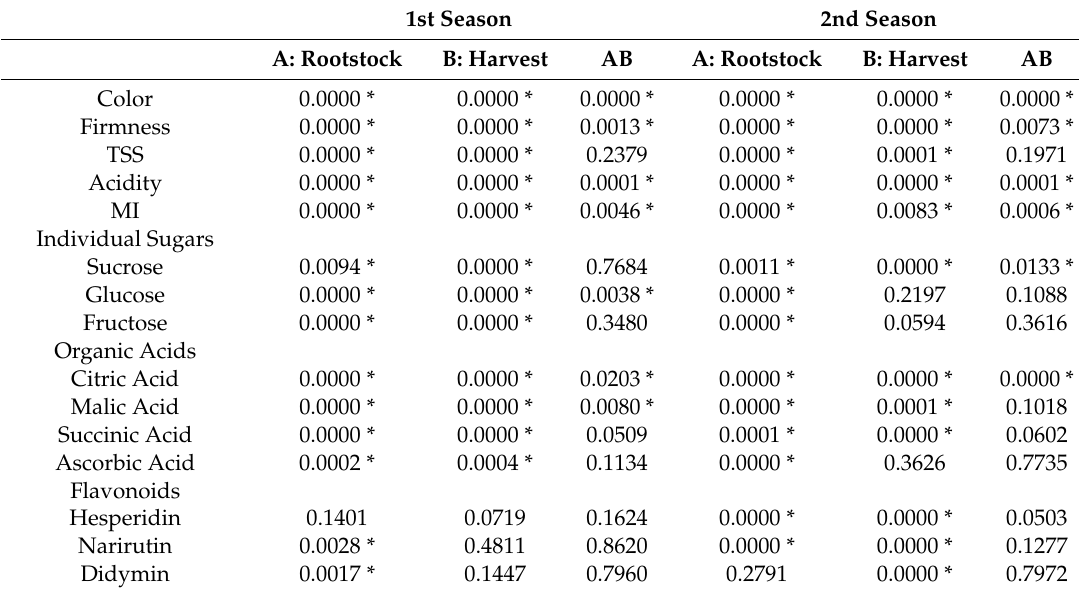
Table 2. p -values ( p ≤ 0.05) of rootstock (A), harvest (B) factors and rootstock-harvest interaction (AB) of the parameters measured of ‘Clemenules’ mandarins grafted onto eight di ff erent rootstocks. * Significant at p ≤